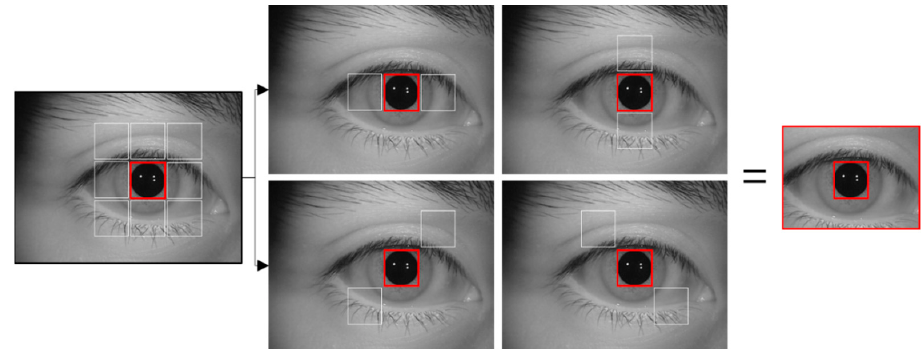
Figure 2. Example of rough iris area detection using sub-block-based template matching.